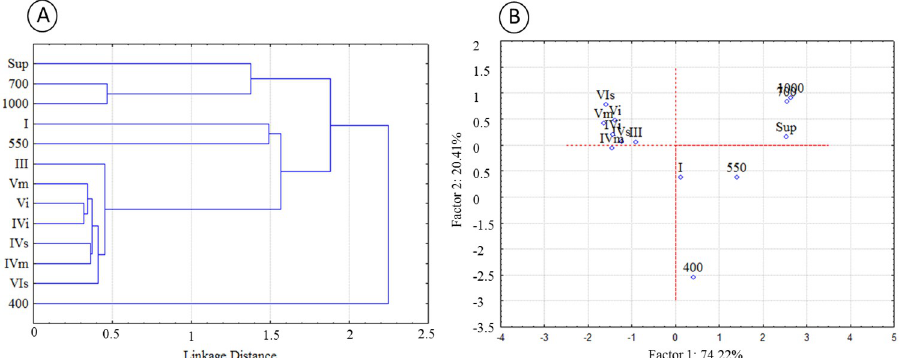
Fig 7. Analysis of the grouping of the samples produced in the muffle oven and collected from the archaeological site: 400, 500 and 700 ˚C; Sup—surface; I—layer I—610 years BP; III—layer III, 1170 years BP; IVs–layer IV- upper; IVm–layer IV-middle; IV- layer IV-lower; Vm–layer V- middle (8500 years BP); VI–V lower; VIs–layer VI